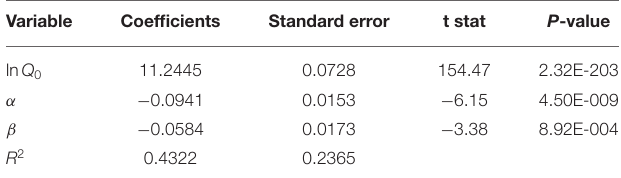
TABLE 2 | Regression results with POOL and OOP .